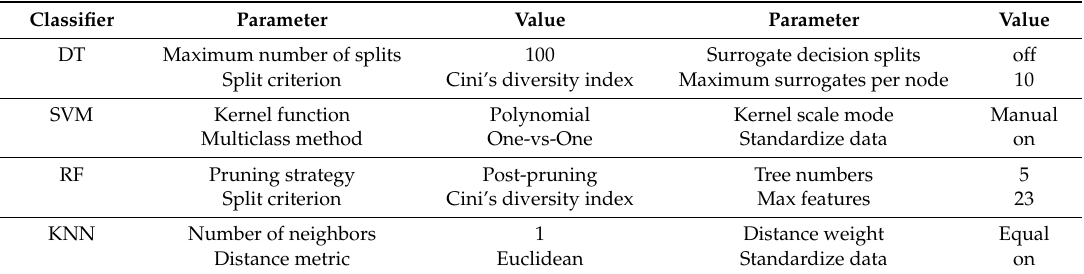
Table 9. Some important parameters of k-Nearest Neighbor (KNN), Decision Tree (DT), Random Forest (RF) and